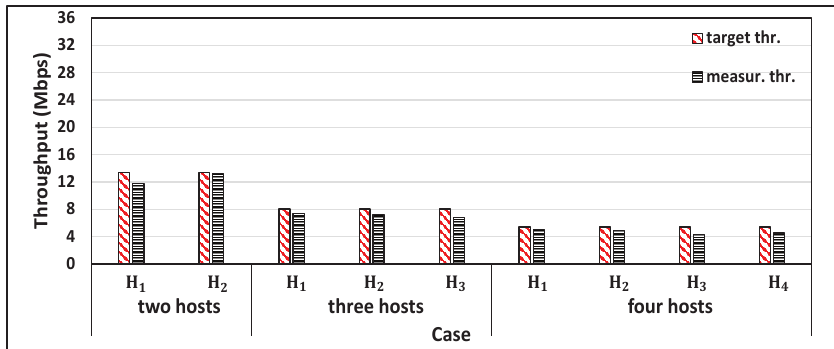
Figure 11. Measurement results of single and concurrent throughputs with web traffic.